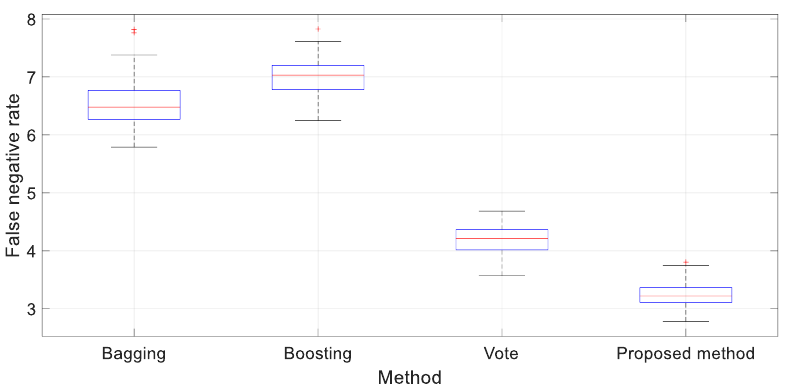
Figure 10. Box diagram of false negative rate.